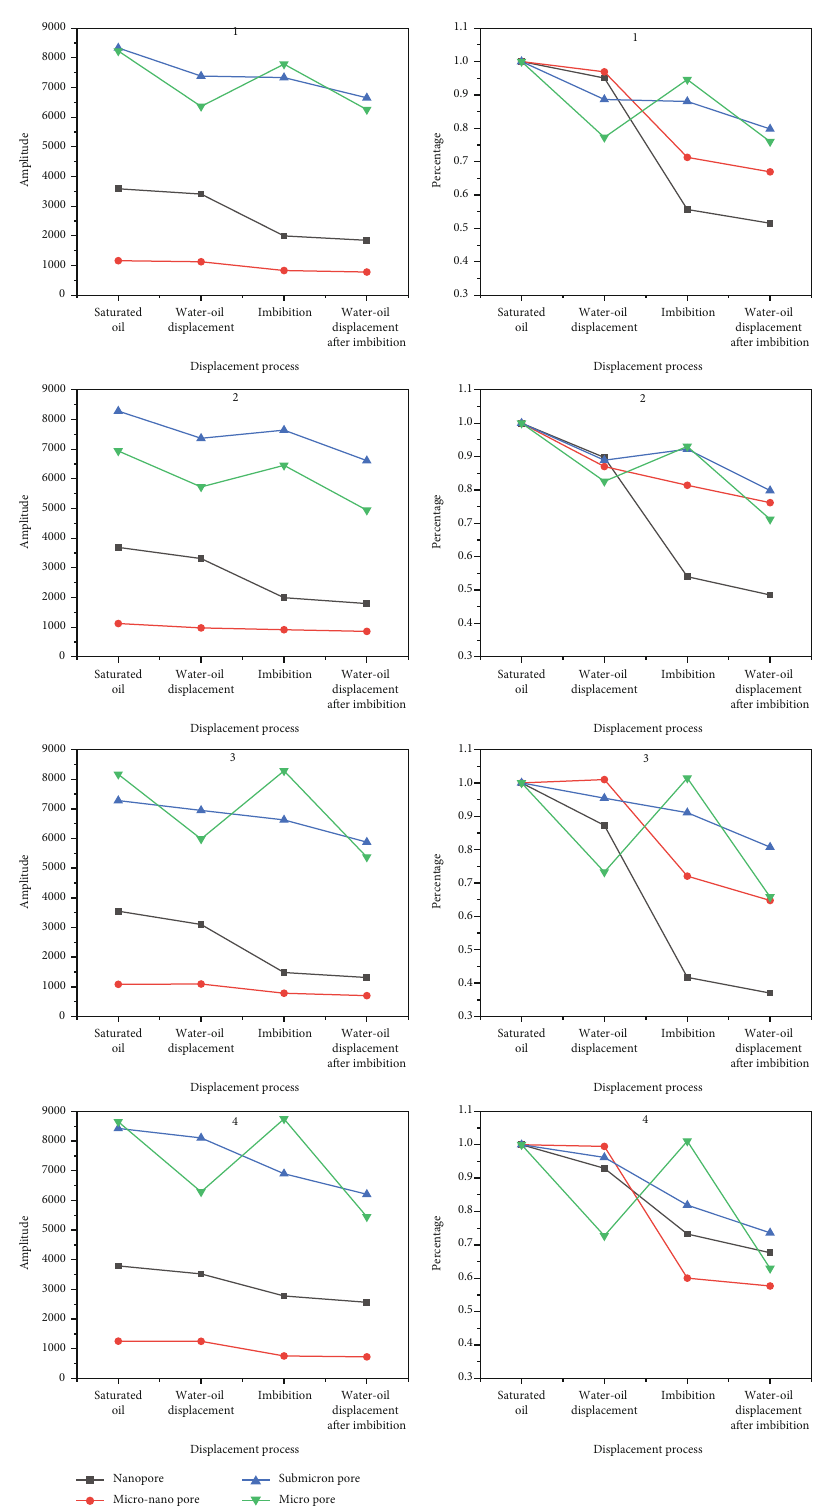
Figure 4: Comparison of the changes in the oil contents of the various types of pores under di ff erent displacement